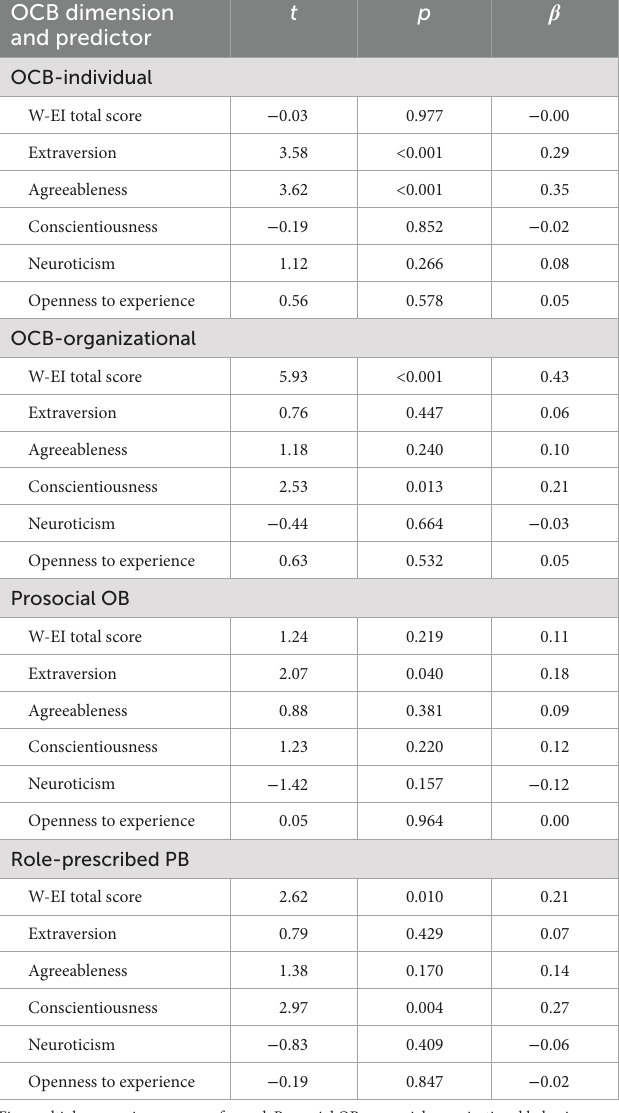
TABLE 6 Work-related emotional intelligence (W-EI) as a predictor of organizational citizenship behavior (OCB), multiple regression results, Study